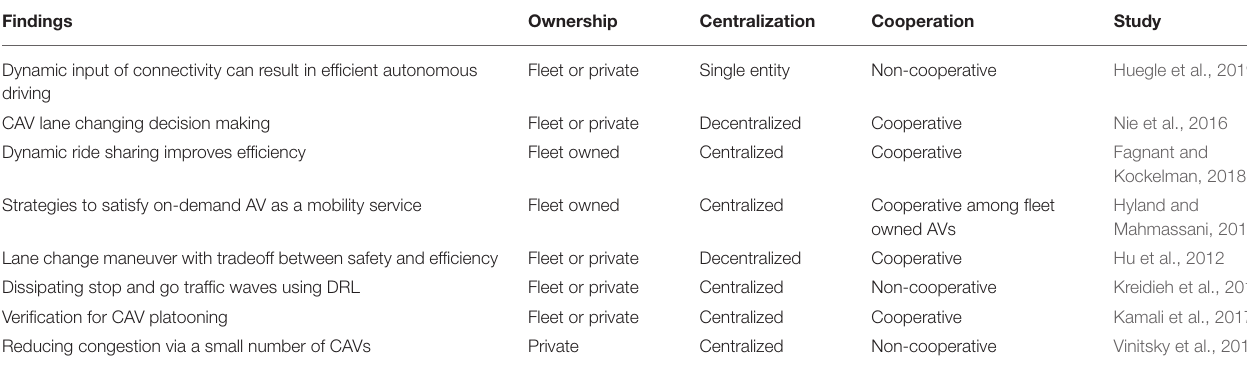
TABLE 2 | Examples of the benefits of connectivity-aided automation.